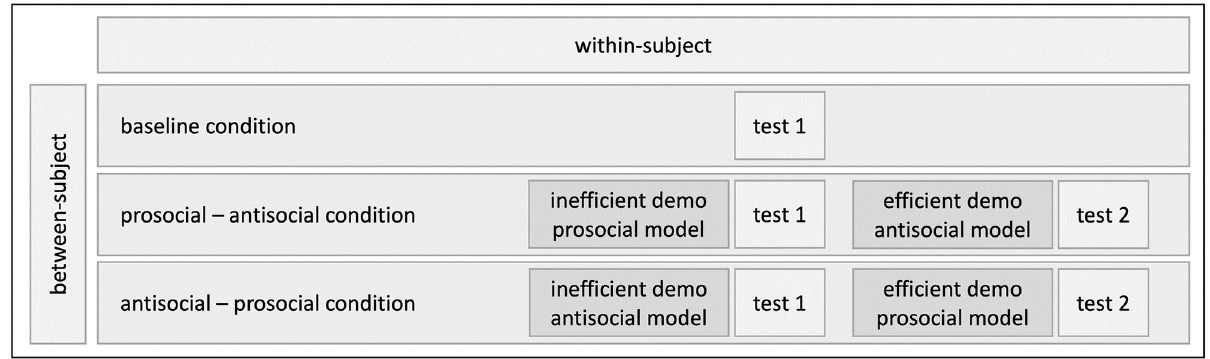
Fig 1. Overview of baseline and experimental